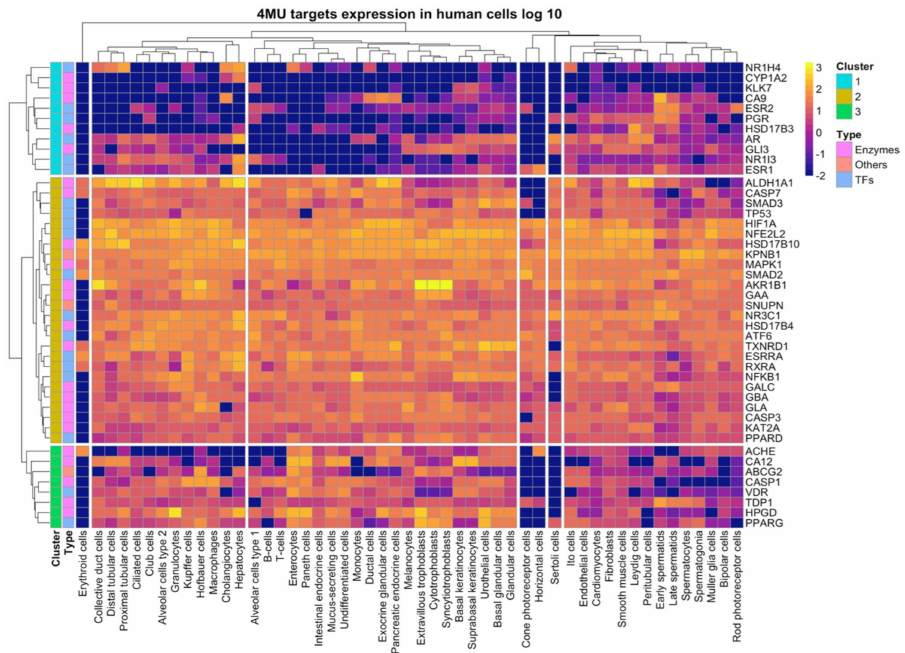
Figure 3. 4MU targets expression across human cell types. The expression levels of individual genes were retrieved manually from the Single Cell RNA-Seq dataset of the Human protein atlas database (www.proteinatlas.org). Data presented in log 10 scale, − 2 values correspond to the undetectable expression